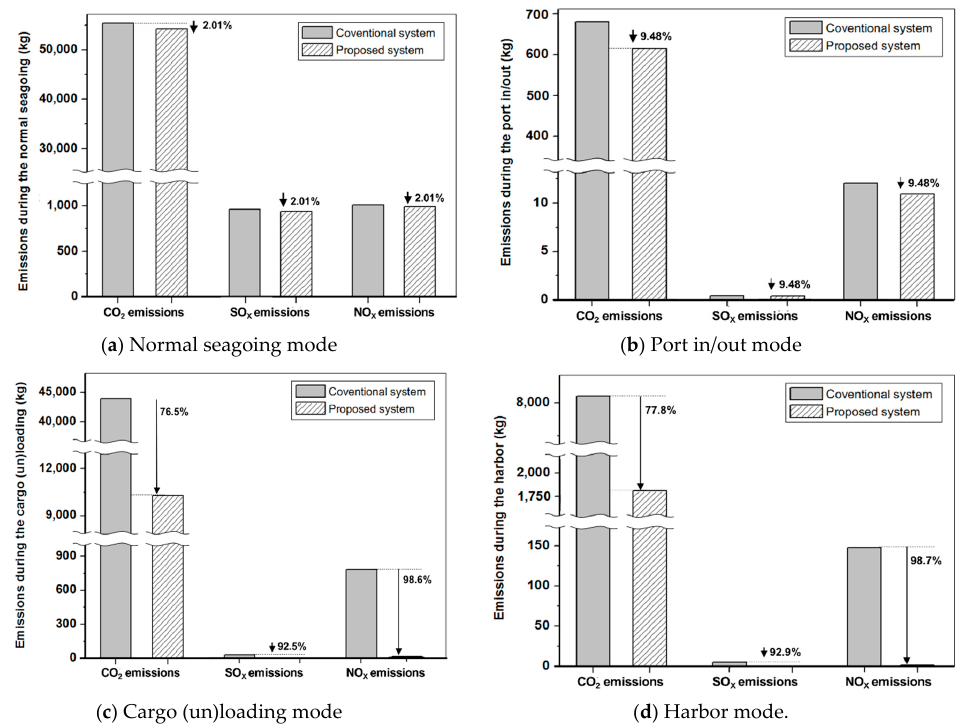
Figure 11. Comparison of emissions for each operation mode.